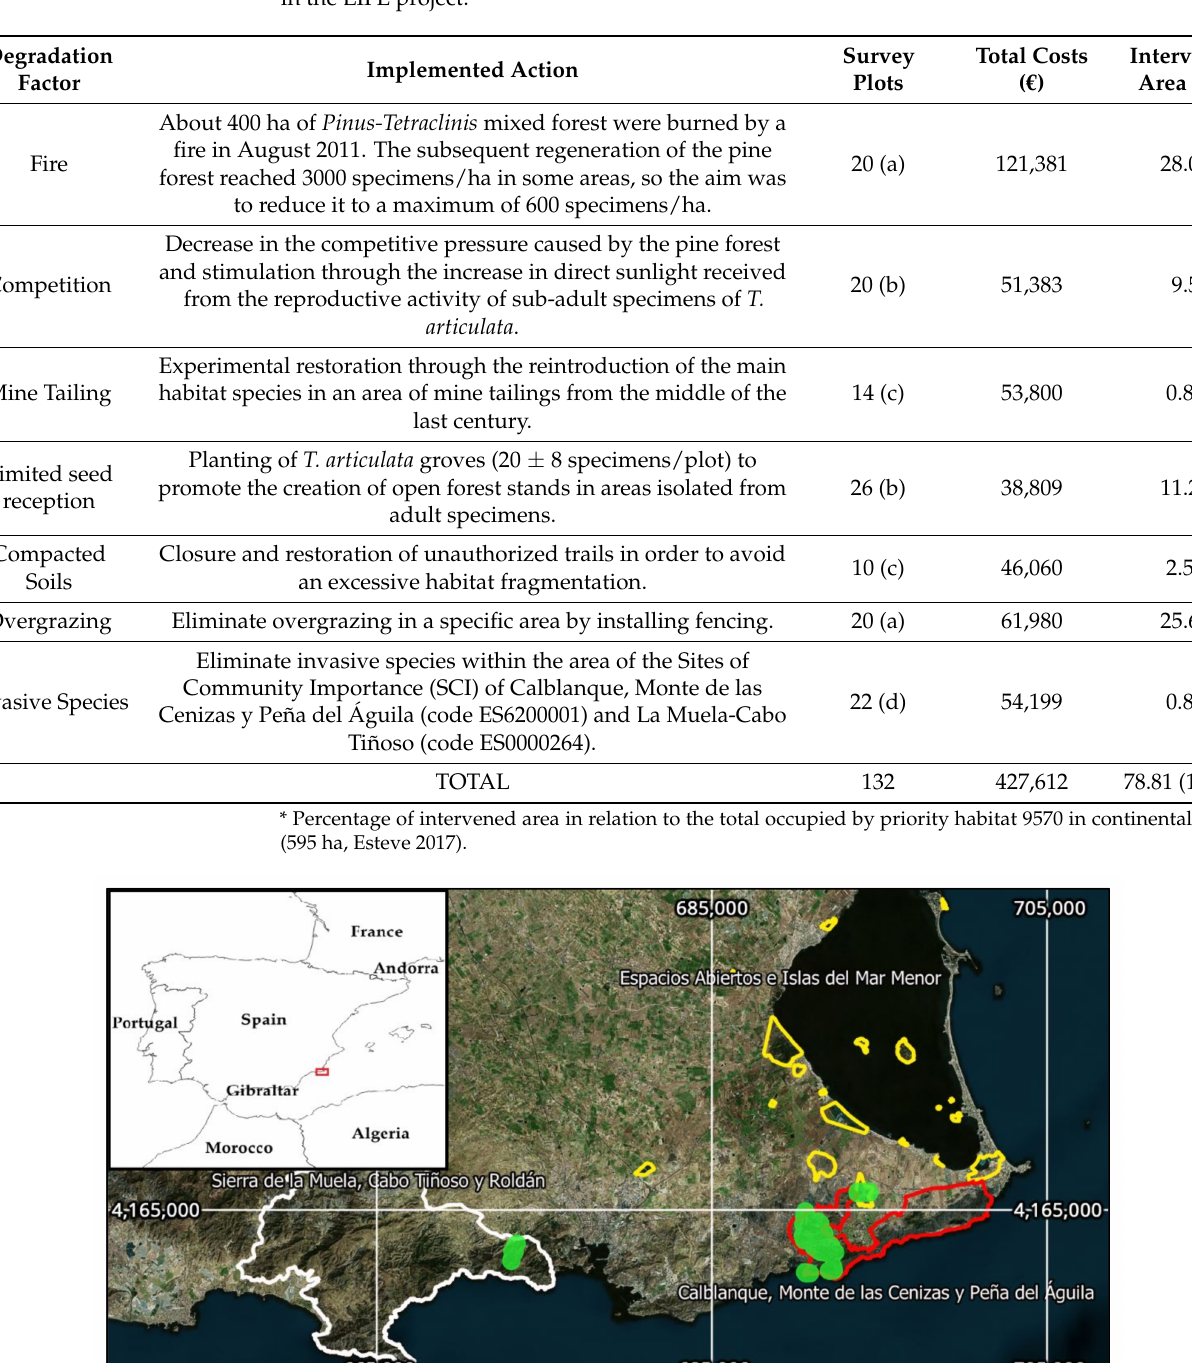
Table 1. Summary of the LIFE- Tetraclinis project actions and number of survey plots. Each plot type was sized according to the nature of the studied degradative factor: (a) square plots of 400 m 2 , (b) circular plots of 15 m radius, (c) square plots of 25 m 2 , and (d) original irregular polygons designed in the LIFE project.